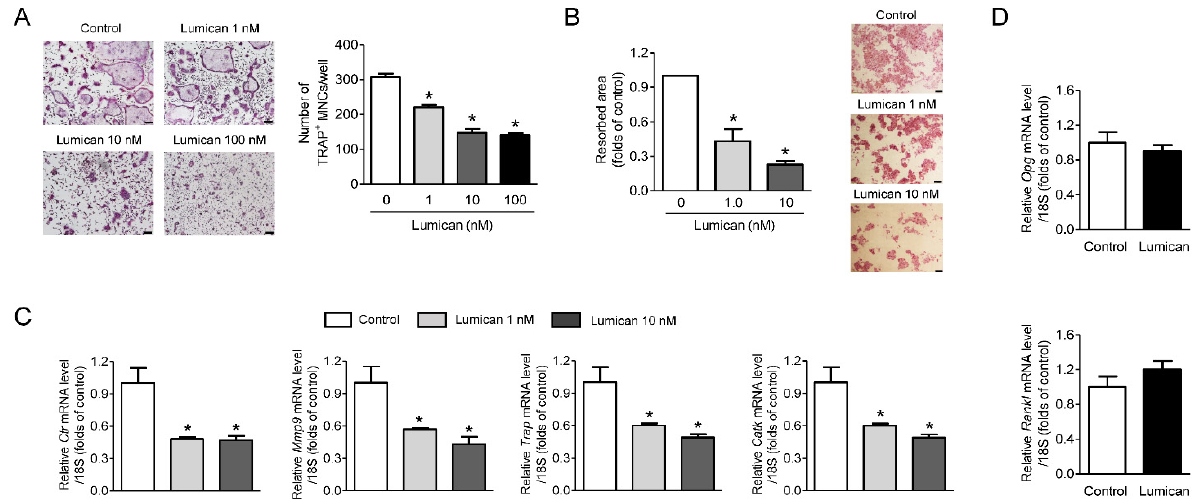
Figure 1. Lumican suppresses osteoclast differentiation and in vitro bone resorption. ( A ) Primary mouse BMMs were cultured for 4 days with 30 ng/mL RANKL, 30 ng/mL M-CSF, and the indicated concentrations of lumican. After the cells were stained with TRAP, TRAP-positive multinucleated cells (MNCs) ( ≥ 3 nuclei/cell) were counted to assess osteoclast differentiation ( n = 5). ( B ) Mouse BMMs were cultured on dentin slices for 10 days in the presence of 30 ng/mL RANKL, 30 ng/mL M-CSF, and 1 nM or 10 nM lumican and stained with hematoxylin to visualize pit formation ( n = 3). ( C ) Quantitative RT-PCR analysis of osteoclast differentiation markers in BMMs exposed to 30 ng/mL RANKL, 30 ng/mL M-CSF, and 1 or 10 nM lumican for 4 days ( n = 4). ( D ) Quantitative RT-PCR analysis to measure Opg and Rankl expression in mouse calvaria osteoblasts exposed for 7 days to 10 mM β -glycerophosphate and 50 mg/mL ascorbic acid, with or without 10 nM lumican ( n = 3). Scale bars: 100 μ m ( A ) and 50 μ m ( B ). Data are means ± SEM. * p < 0.05 vs. untreated control.